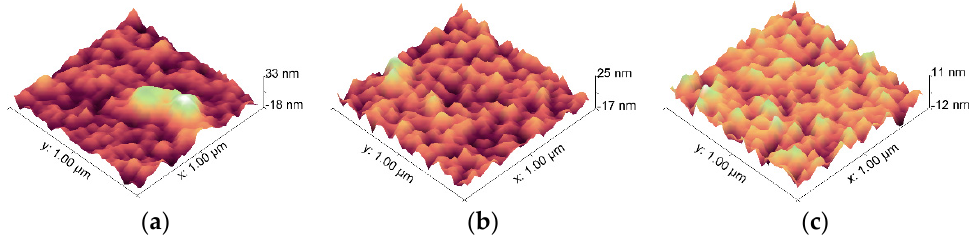
Figure 5. 3-D morphology of silicon nitride thin-film by atomic force microscopy (MFP-3D). ( a ) Silicon nitride thin-film; ( b ) Silicon nitride film with Aluminum oxide transition layer; ( c ) Silicon nitride film with TiN transition layer.